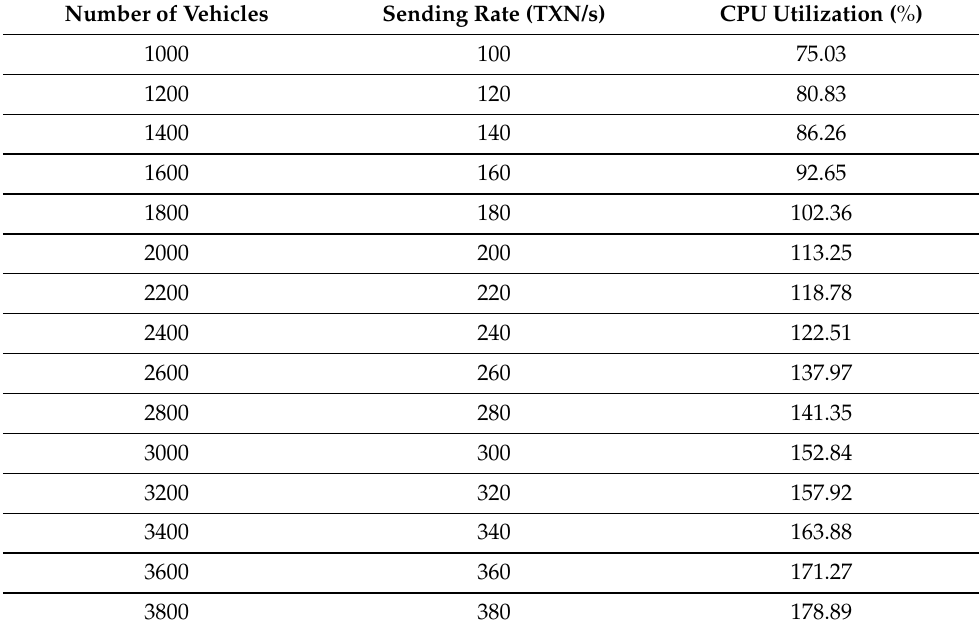
Table 1. Reference CPU utilization